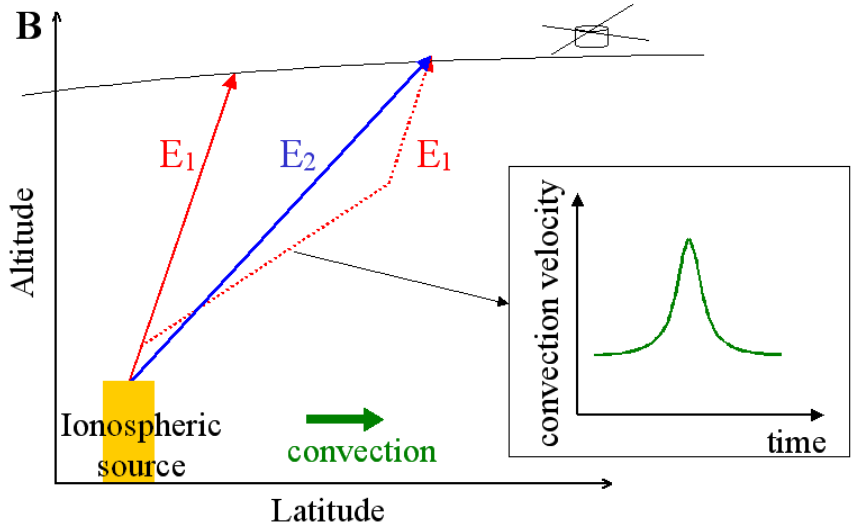
Fig. 5. Schematic description of the effect of a pulse of the convection electric field on the particle path. E 1 and E 2 refer to the particle energy: E 1 > E 2 . Solid lines: regular velocity filter effect. Dashed line: effect of a pulse of convection